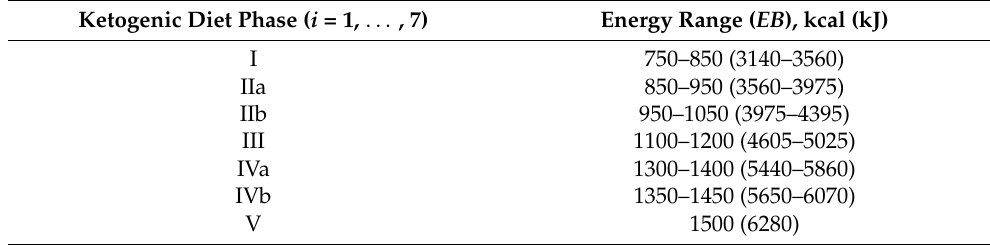
Table 2. Permissible ranges of energy intake with regard to the phase of the ketogenic diet. Ketogenic Diet Phase ( i = 1, . . . ,